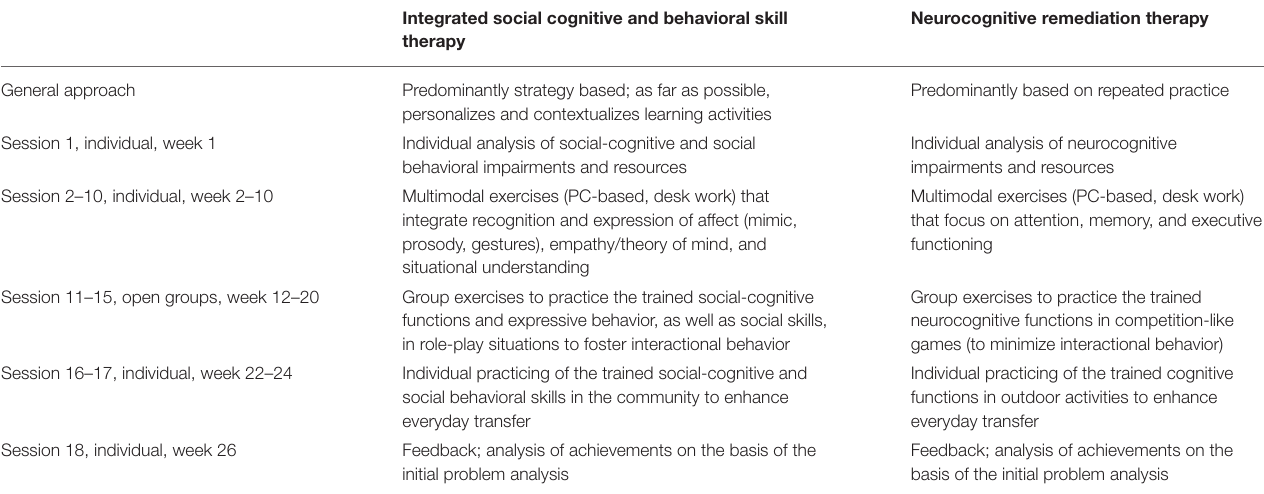
Integrated social cognitive and behavioral skill therapy